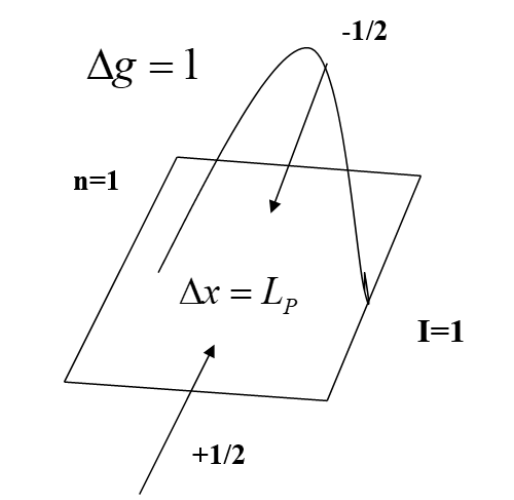
Figure 13. The uncertainty in the position state of the boson field at the Planck